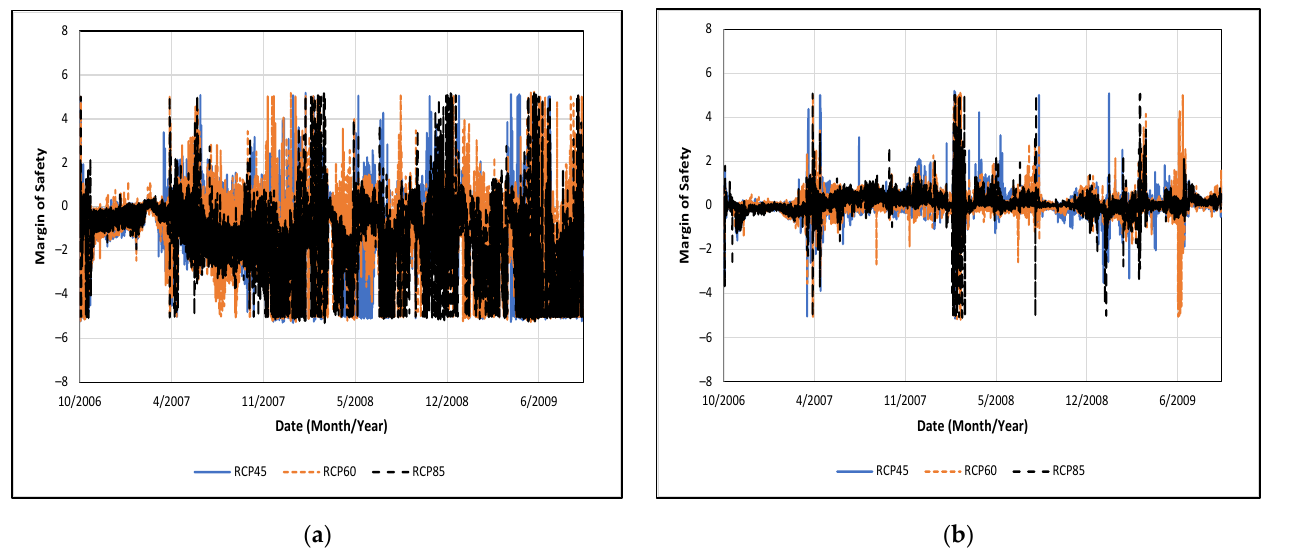
Figure 5. Suggested Margins of Safety for Theoretical WQT Buyer TN over the Jordan River Simulation (1 October 2006 to 30 September 2009) for the Downstream Trade Ratio Component with Population Characteristics only under Distinct RCP Projections (RCP45 = RCP 4.5; RCP60 = RCP 6.0; RCP85 = RCP 8.5) for Inflow Increase of 1.15 among ( a ) Buyer TN to Seller TP and ( b ) Buyer TN to Seller BOD.